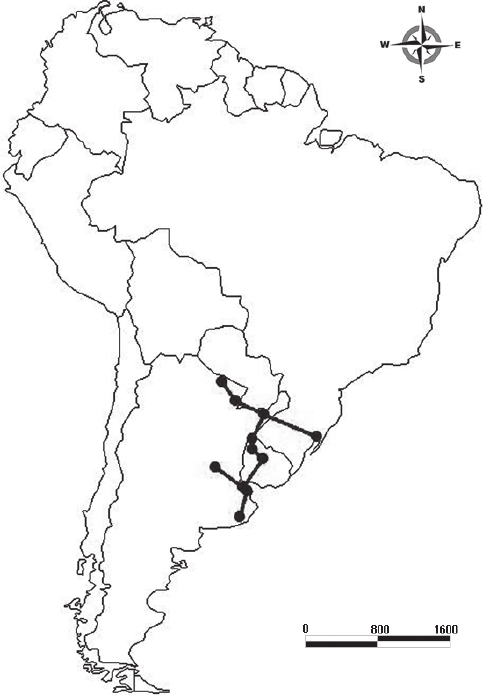
Fig. 18 - Individual track of P. typum .